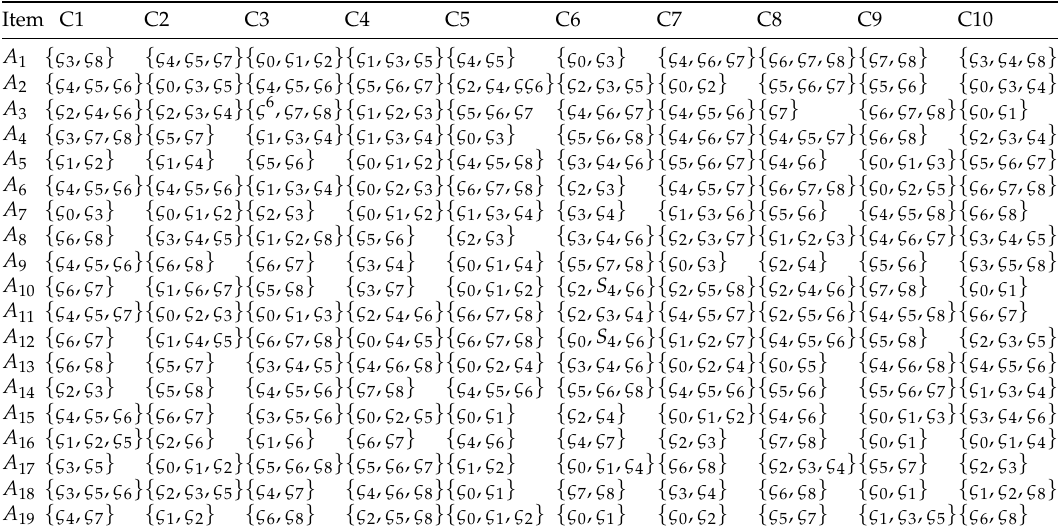
Table 2. Decision matrix Y 1 with respect to decision makers 1, 2, and